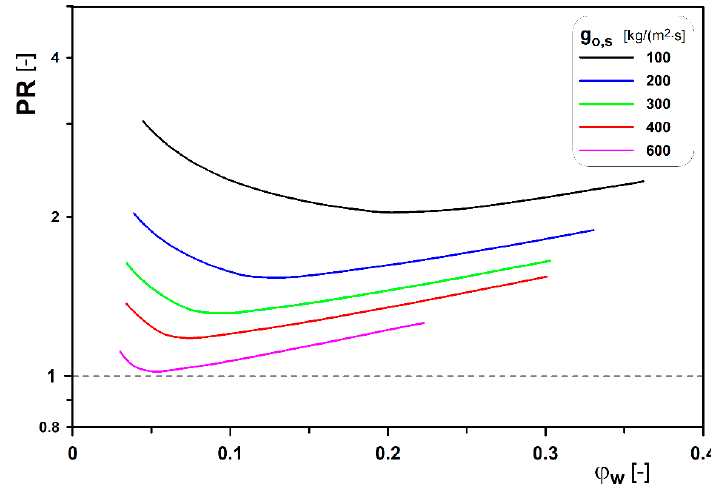
Energies 2021 , 14 , x FOR PEER REVIEW Figure 8. Variations in PR index for oil with the viscosity of η r =25. Figure 8. Variations in PR index for oil with the viscosity of η